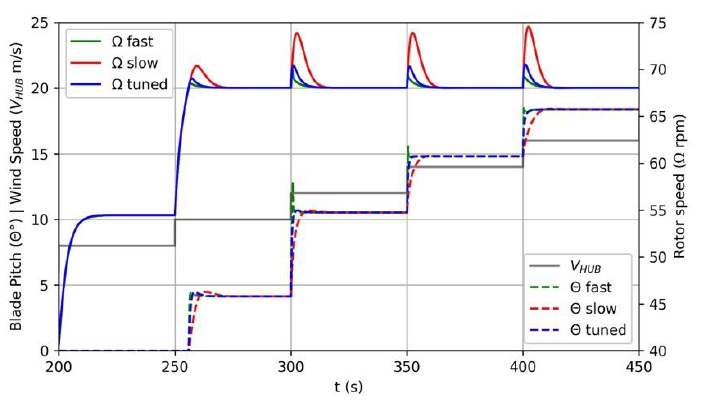
Figure 5. Turbine response to step-wind profiles for different values of controller natural frequency and damping ratio. Design natural frequency ( ω des ) = 0.82 and damping ratio ( ξ des ) = 1.4 for the tuned case, ω des = 1.2 and ξ des = 2 for the “fast” case, and ω des = 0.4 and ξ des = 0.8 for the “slow” case. Values for the “slow” case were still greater than those typically employed on utility-scale machines.